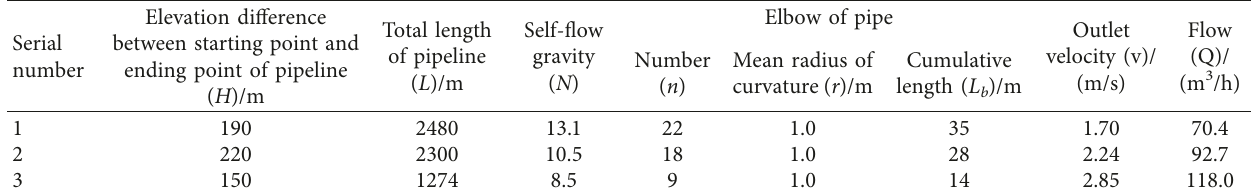
Table 2: Experimental results of large gravity self flow.